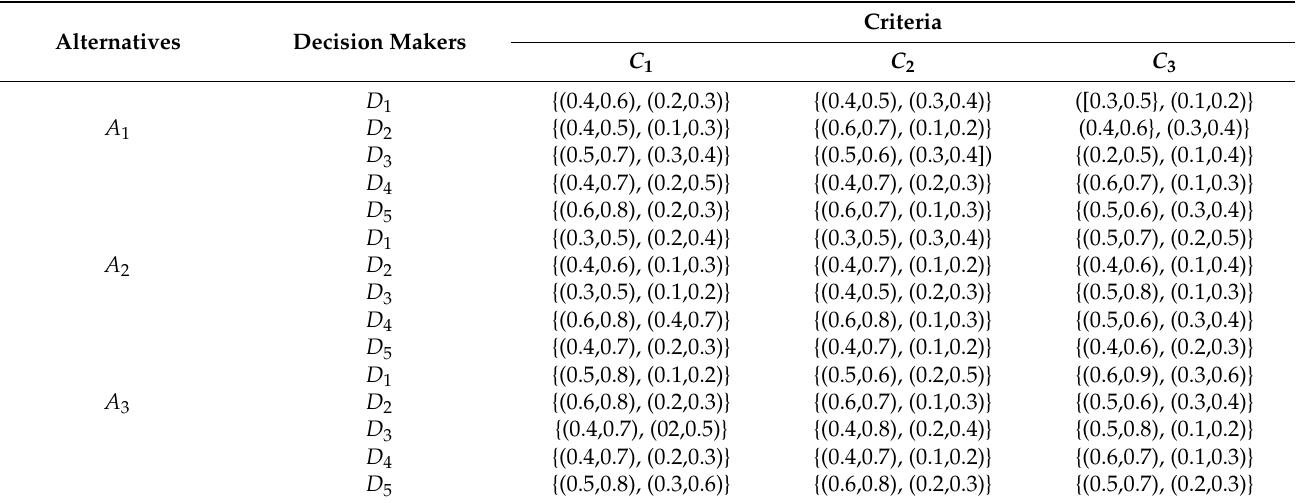
Table 1. Interval-valued intuitionistic fuzzy decision matrix.